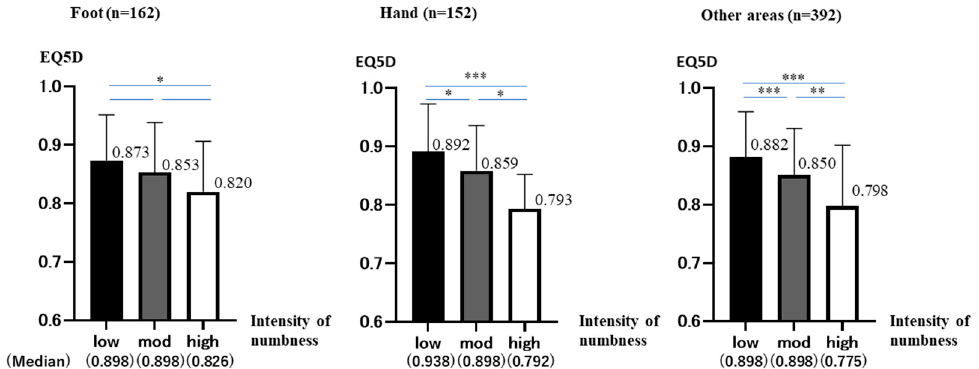
Figure 3. Each site of numbness was analyzed separately as foot, hand, and other areas. EQ5D is on the vertical axis, and the intensity of numbness is on the horizontal axis. The graph shows the mean and standard deviation (95%CI) of EQ5D in each group ( p < 0.05 *, < 0.01 **, < 0.001 ***).